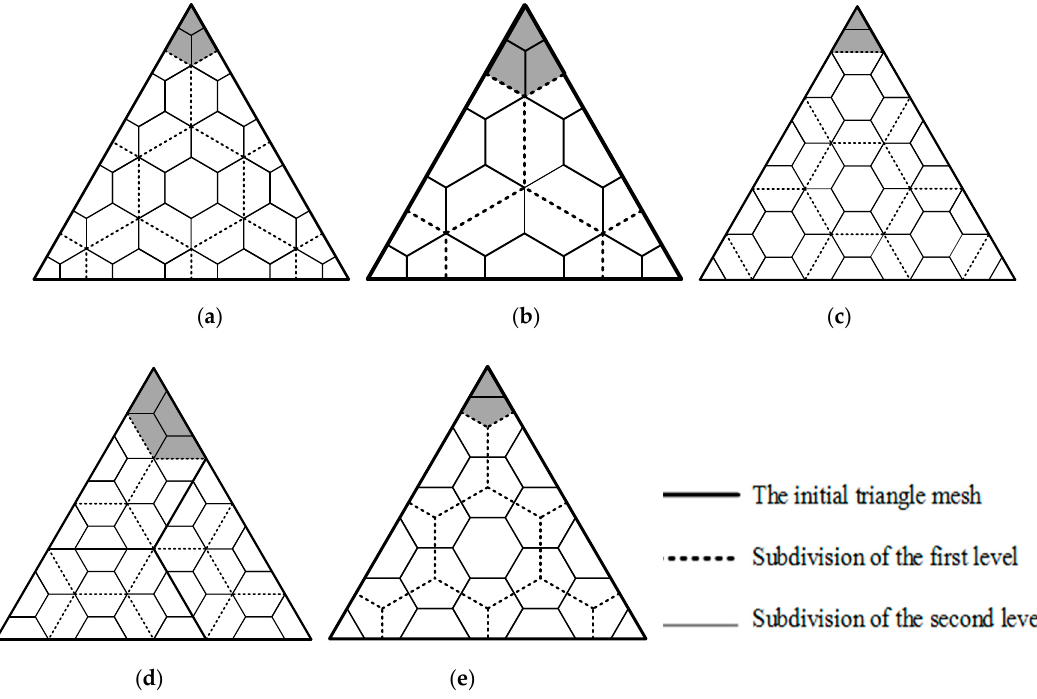
Figure 5. Hexagonal Grids with aperture 3 and aperture 4 subdivision. ( a ) class I aperture 4 grid; ( b ) class II aperture 4 grid; ( c ) class III aperture 4 grid; ( d ) class IV aperture 4 grid; and ( e ) aperture 3 grid.